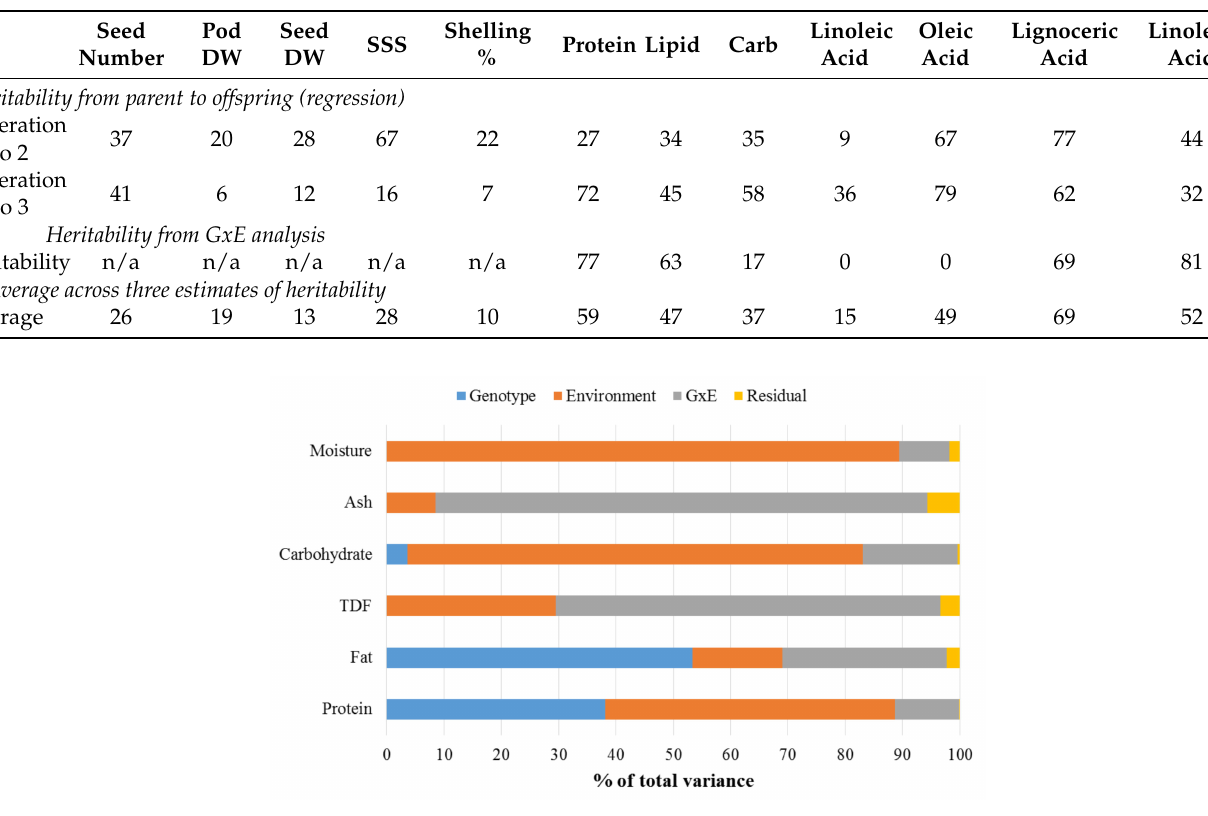
Figure 3. Proportions of total variation and the relative contribution of genotype (G-blue), growing environment (E-orange), and their interactions (GxE-grey) to proximate nutritional components (moisture, ash, carbohydrate, total dietary fibre (TDF), lipid, and protein) using six bambara ground- nut lines grown in Malaysia and United Kingdom. Variance components for genotype, environment, GxE, and residual were estimated using restricted maximum likelihood (REML)